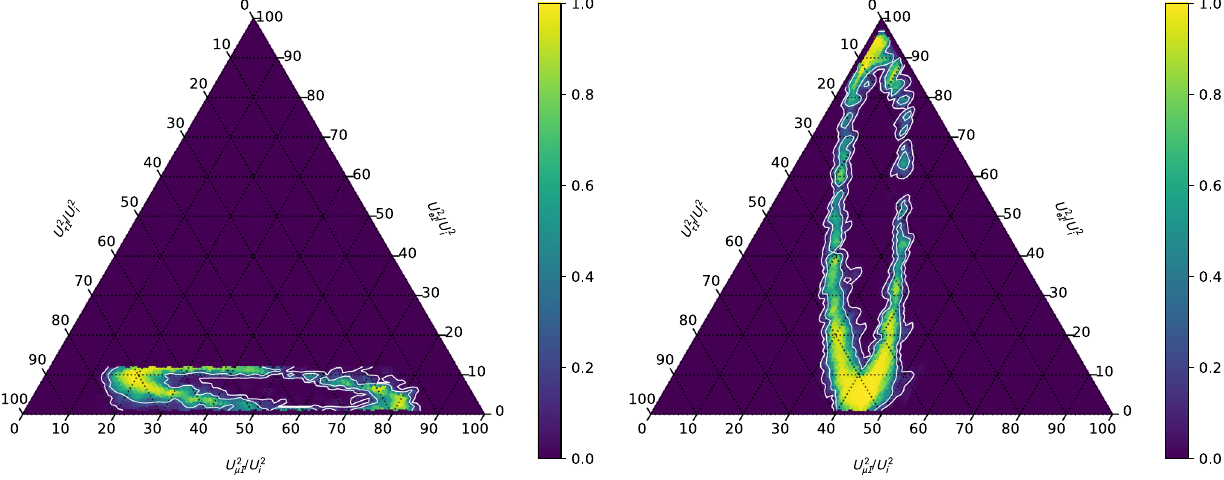
/ U 2 (in percent) in the limit of n = 2 in the symmetry protected region for normal (left) and inverted (right) I I